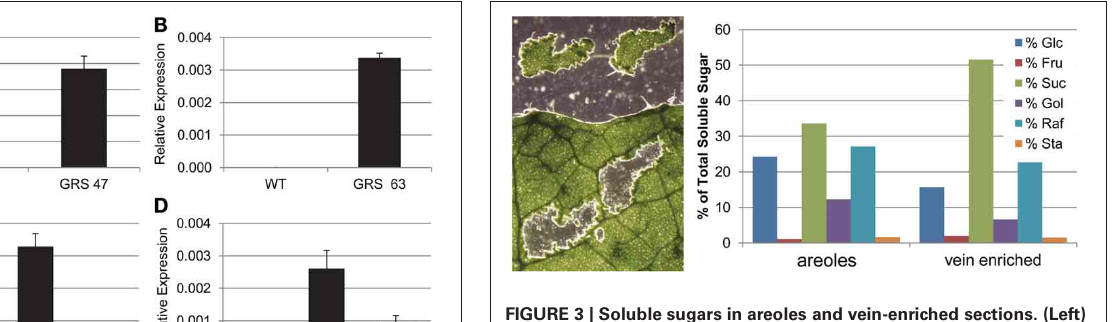
FIGURE 3 | Soluble sugars in areoles and vein-enriched sections. (Left) Representative leaf that was flash frozen on powdered dry ice, lyophilized, and micro-dissected for areoles (sections containing only mesophyll cells and associated epidermis surrounded by minor veins). Vein-enriched sections (not shown) contained the minor veins and closely associated mesophyll that bordered the areole sections. (Right) Distribution of soluble sugars in pooled areoles and pooled vein-enriched sections, expressed as percentage of total detected